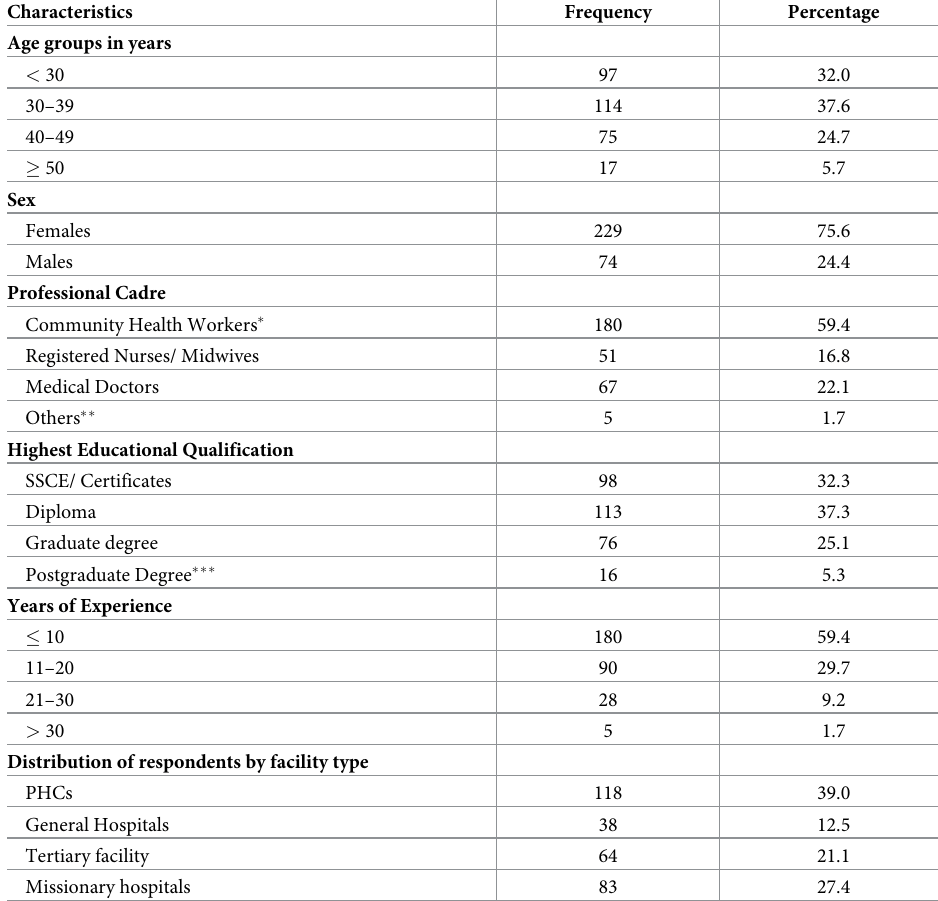
Table 1. Sociodemographic characteristics of health workers, Ebonyi state (N =